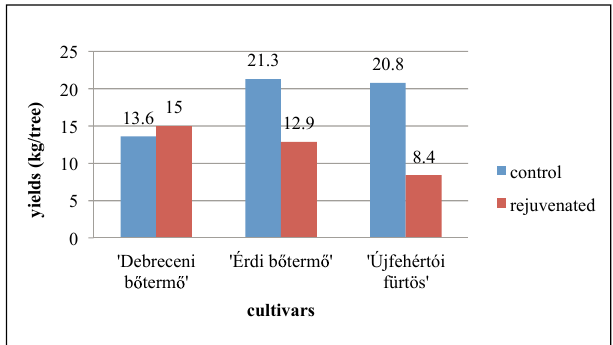
Figure 3. Yields of the control and the rejuvenated trees two years after the pruning (Debrecen – Pallag, 2015).